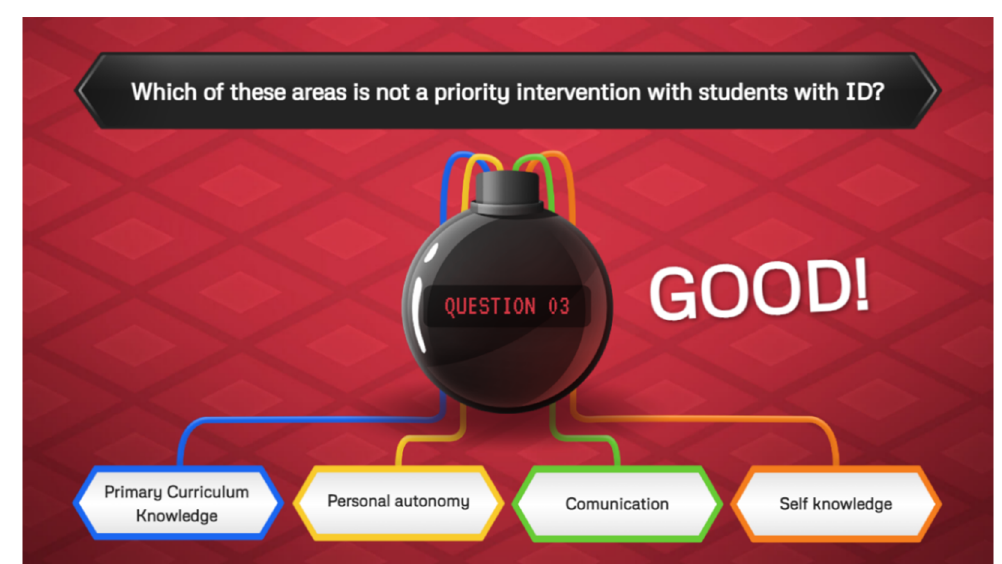
Figure 1. Quiz on the syllabus of the subject in the escape room.